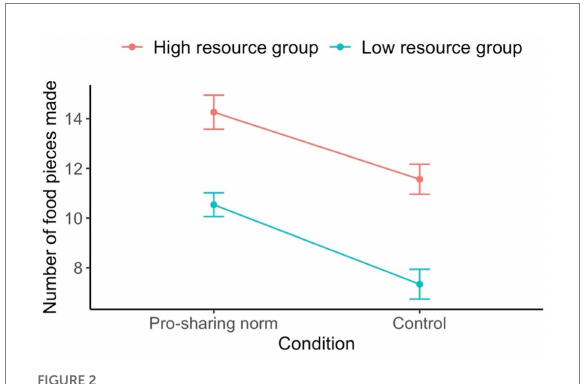
FIGURE 2 Number of food pieces made by individuals on average per condition and resource group for Study 3. Error bars represent standard